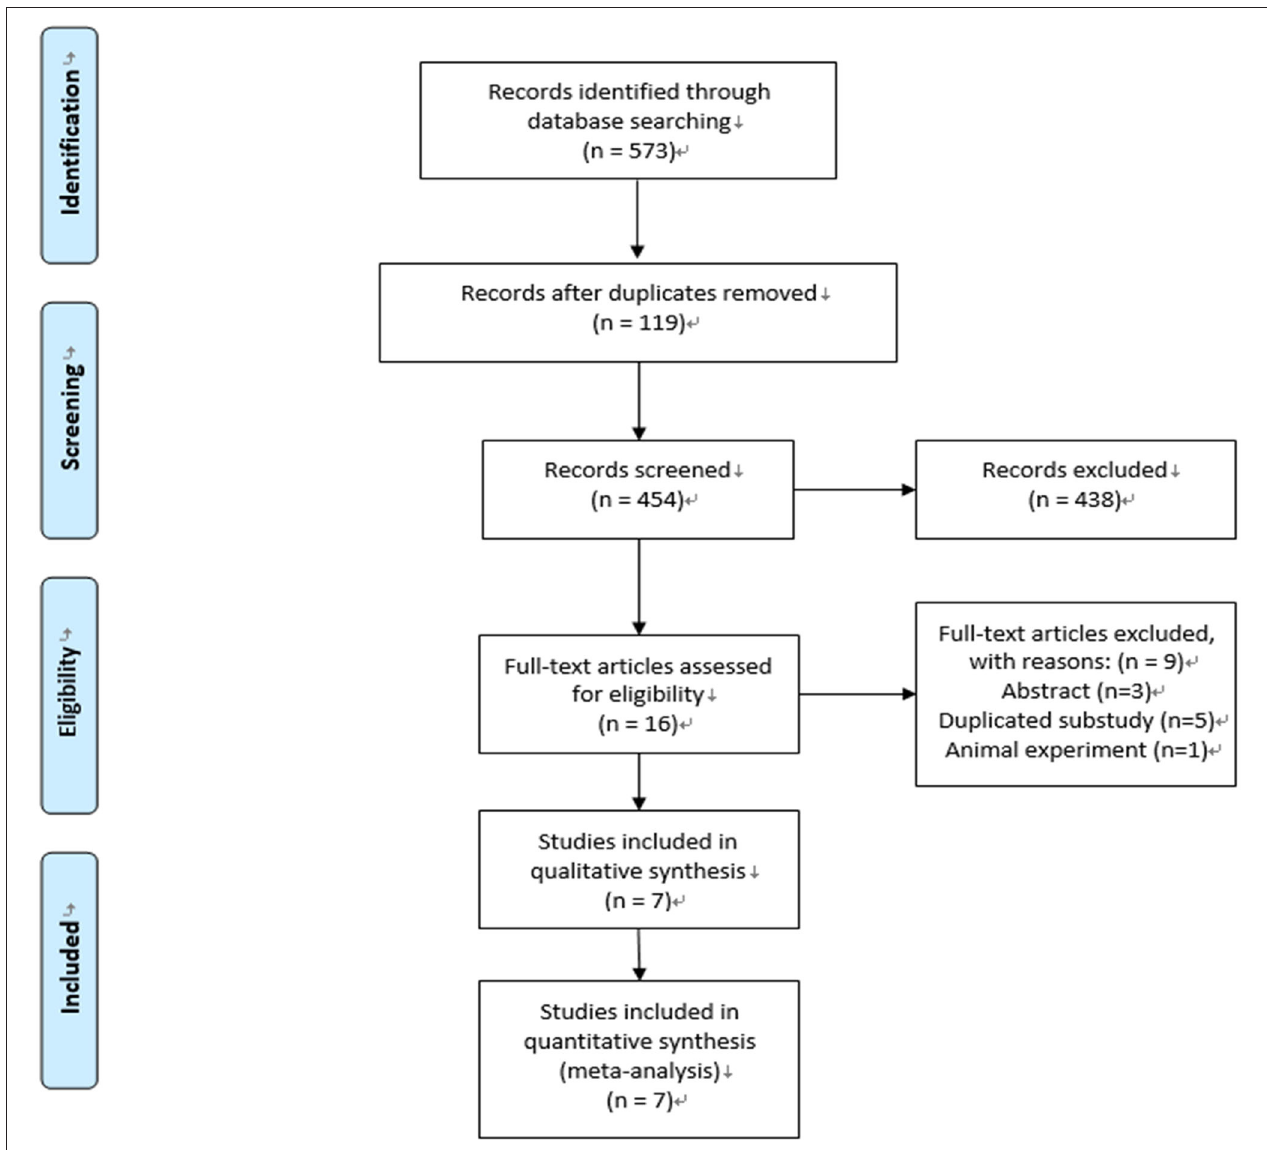
FIGURE 1 | Flow chart of study selection and